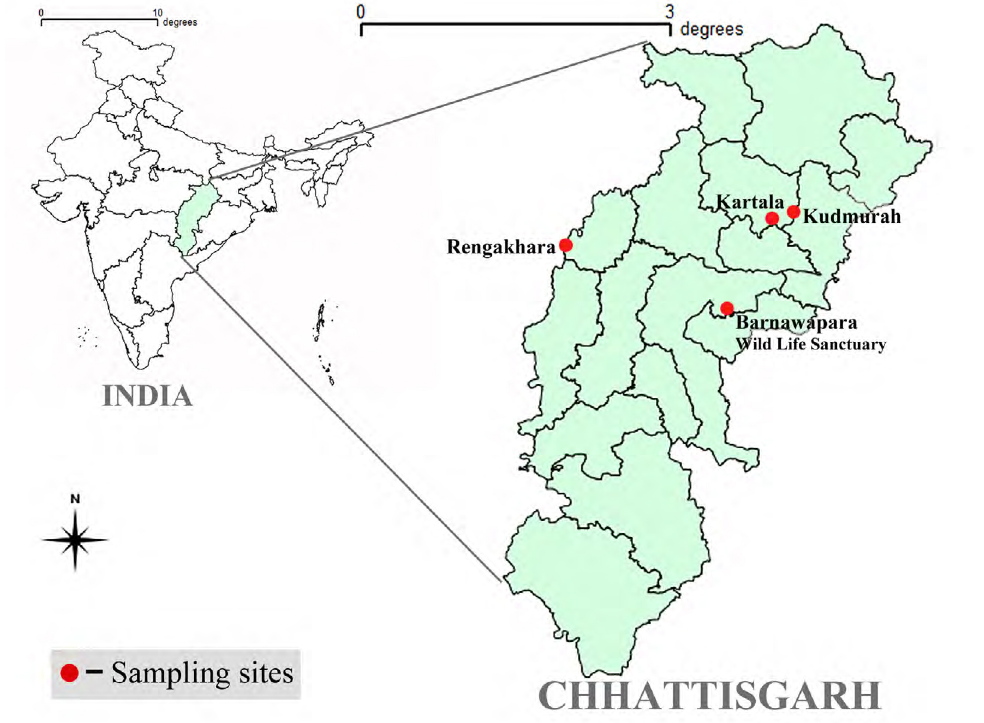
Figure 3. Map of Chhattisgarh, India, indicating the sampling left paraproct (LPPT) small, horizontal, pointed at both ends. The distinct sub-apical spine present on the outer side of the major process on the right hemitergite (10RP 1 ) [Figure 2B.i]. Left cercus basipodite (LCB) complete ring with a prominent inner lobe prolonged along inner side of Material examined left circus, as a narrow caudal process [Figure 2A.ii]. : 10LP elongated slightly con- : India: Chhattisgarh: Korba: Kud- stricted at the base, rather club-shaped with rounded apex and bearing two well separated spines on the left side [Figure1E.i]. Ninth sternite (H) broad basally but gradually narrowed towards the left cercus to a process (HP) bearing a number of short, conical spines [Figure 1F]. Distinct LPPT is present and broad, hooked inwards and upwards Material examined terminally and acutely pointed beneath HP [Figure 1E].